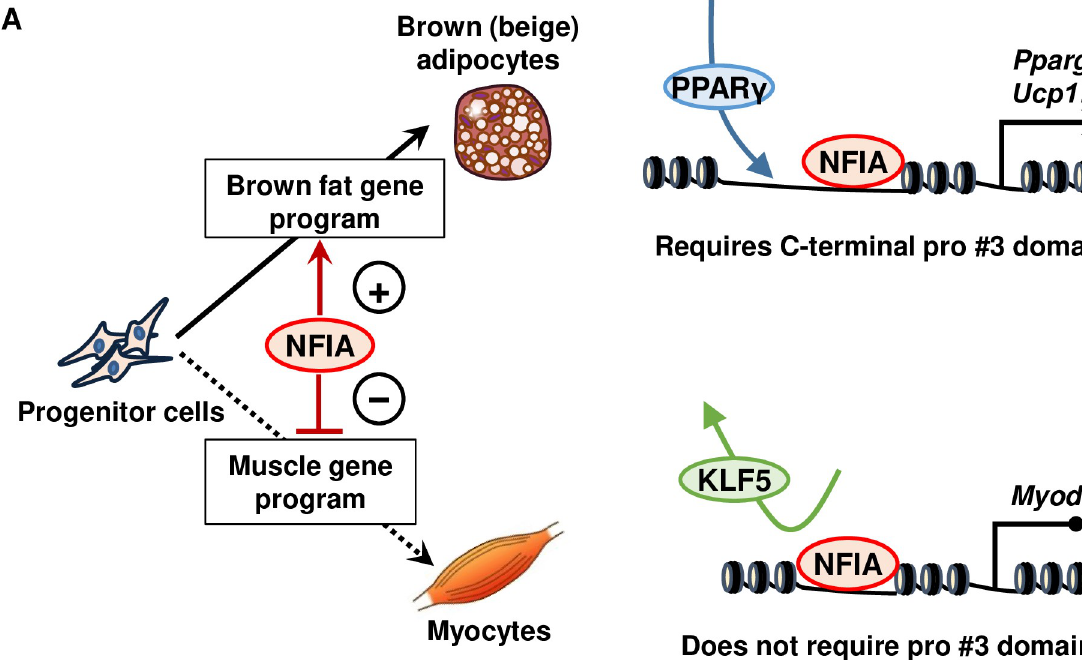
Fig 8. Proposed model of the effect of NFIA on cell fate determination between myocytes and brown/beige adipocytes. (A) NFIA activates Pparg2 expression through its C-terminal pro#3 domain and co-localizes with PPAR γ to control the brown fat gene program. On the other hand, the domain is dispensable for suppression of muscle gene expression through direct suppression of Myod1 via competition with KLF5 in terms of enhancer binding, in a PPAR γ -independent manner.